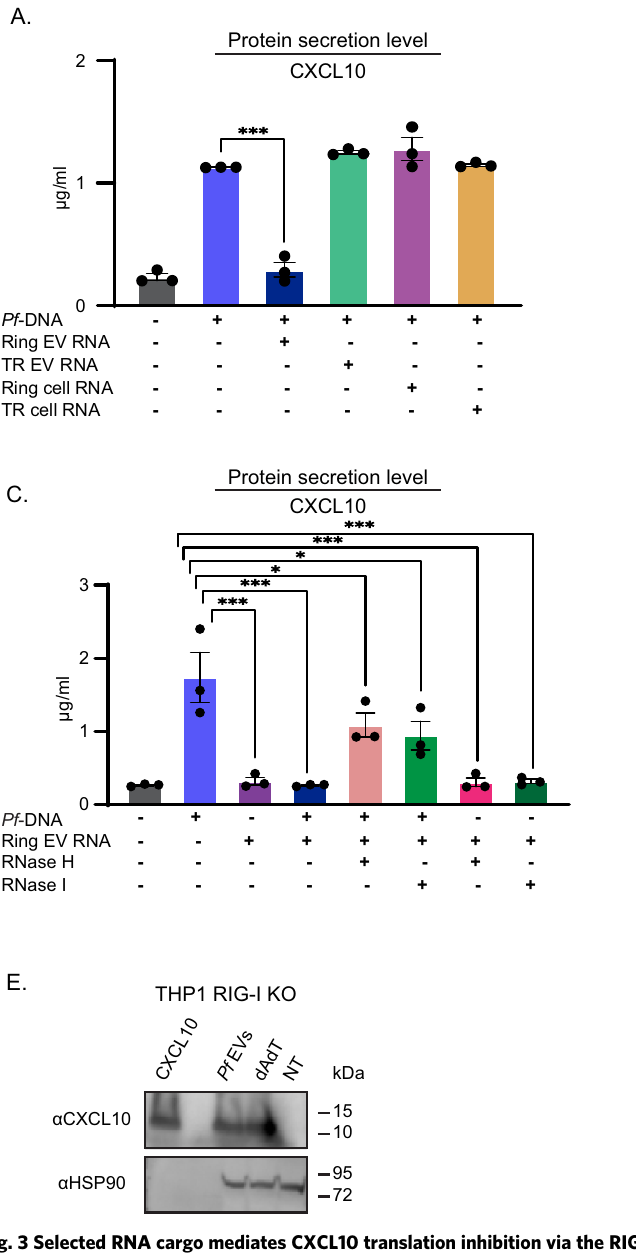
Fig. 3 Selected RNA cargo mediates CXCL10 translation inhibition via the RIG-I receptor. A THP-1 cells were transfected with RNA puri fi ed from: Pf ring stage, trophozoite stage, Pf -ring-stage-derived EVs or EVs derived from Pf -trophozoite-(TR) stage. In addition, all the cells were transfected with Pf